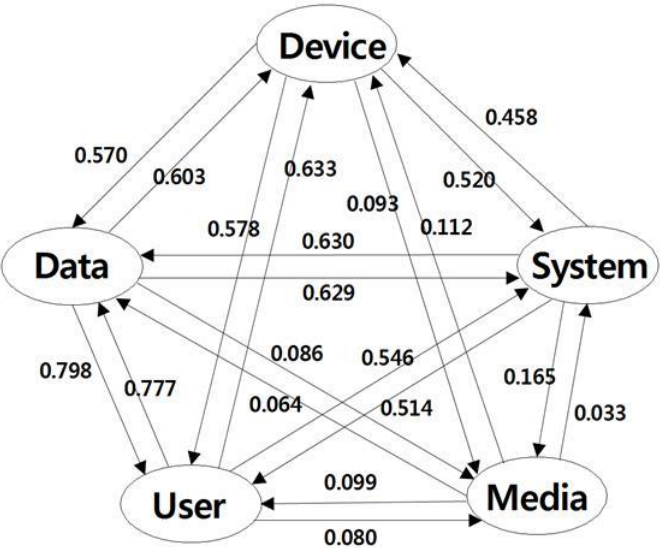
Figure 6. Copula direction dependence of Apple’s keywords.